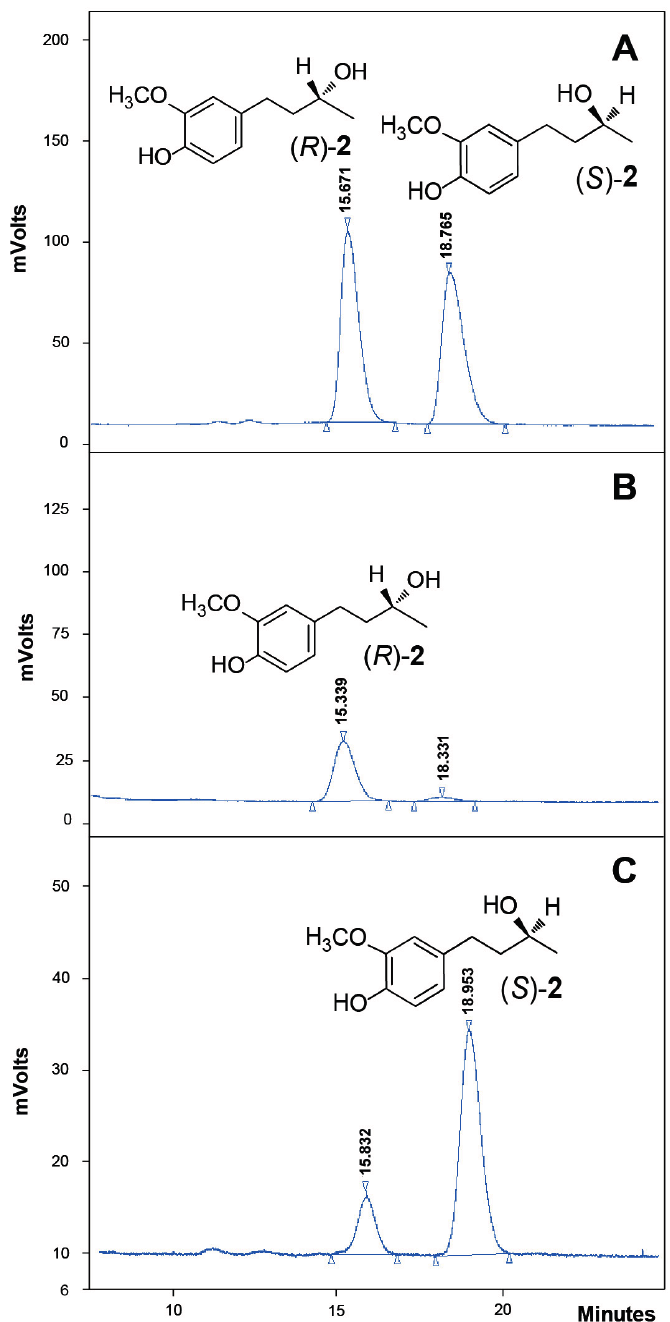
Figure 5. Chromatograms obtained by chiral HPLC of rac - 2 ( A ); ( R )- 2 , Retention Time (RT) = 15.7 min ( B ) and ( S )- 2 ; RT = 18.7 min ( C